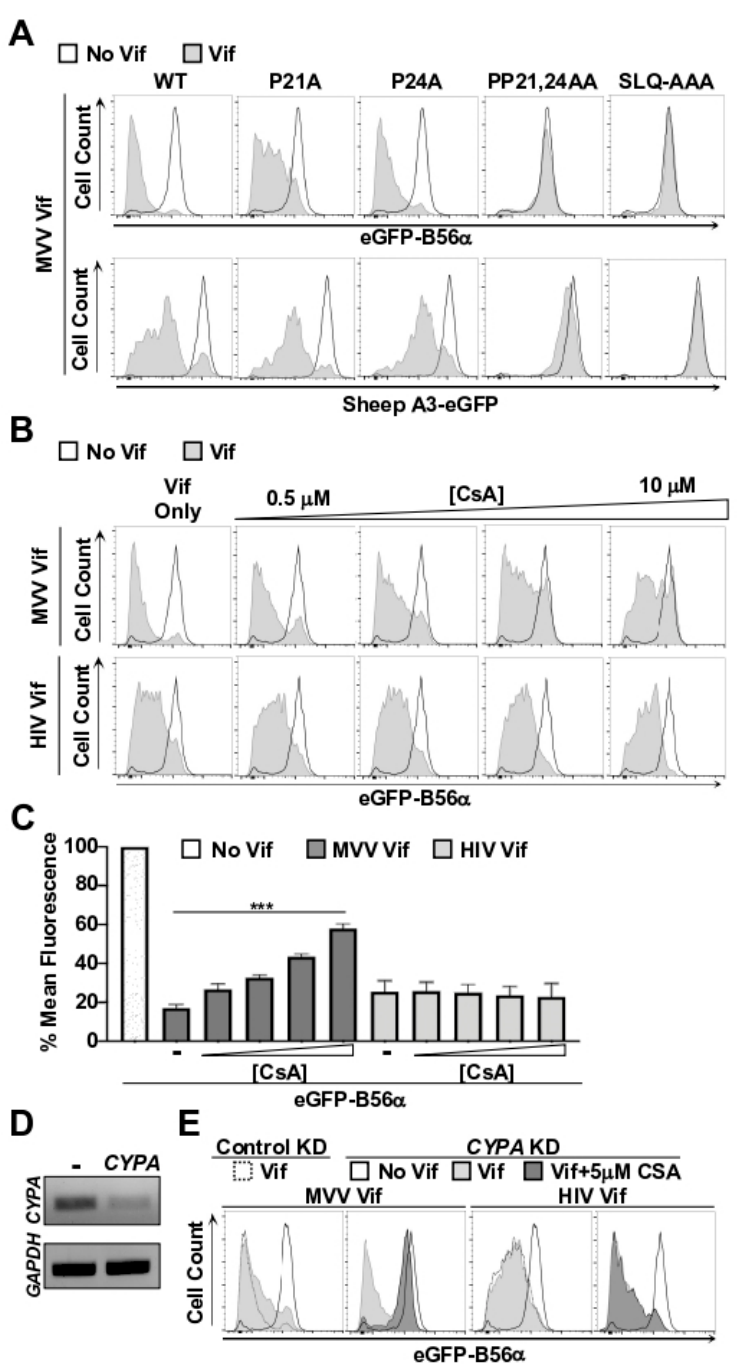
Figure 2. CYPA is required for MVV Vif-induce degradation of B56 proteins. ( A , B ) Flow cytometry histograms were generated as described in Figure 1. For cyclosporin A (CsA) treatments, the indicated concentration of inhibitor was added to samples transiently expressing either HIV or MVV Vif proteins. ( C ) Quantification of eGFP mean fluorescence intensity from cells expressing the indicated Vif proteins with or without increasing concentration of CsA treatment. *** is p < 0.001 by an unpaired student’s t -test. ( D ) RT-PCR analysis of HEK293FT eGFP-B56 α cells stably expressing the indicated shRNA control or CYPA knock-down constructs. ( E ) Flow cytometry histograms were generated as described in Figure 1. Dashed lines represent eGFP-B56 α cells expressing a shRNA control vector and solid lines represent eGFP-B56 α cells expressing a CYPA knock-down construct. All experiments were repeated at least three independent times.